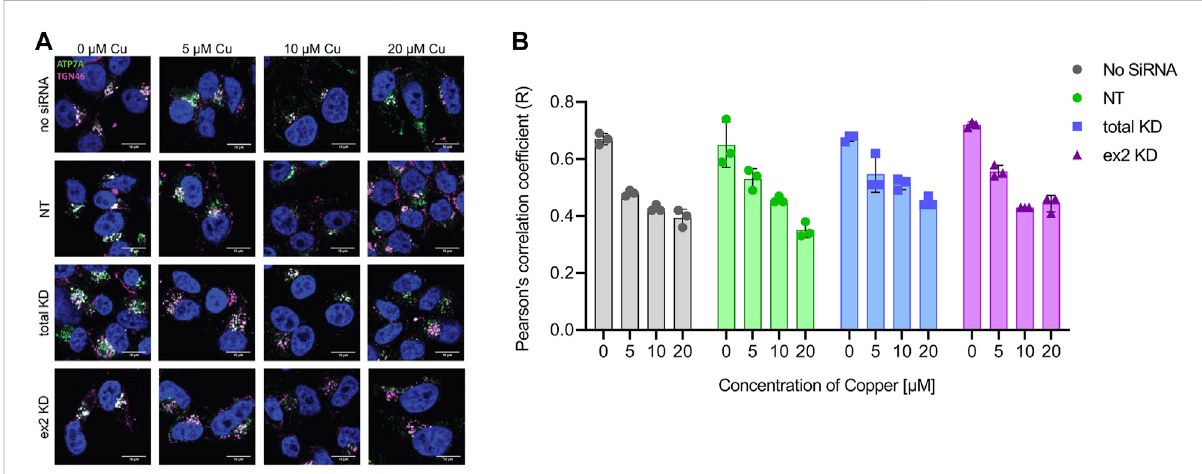
FIGURE 3 hnRNPA2/B1 downregulation in HeLa cells does not affect the traf fi cking of ATP7A in response to Cu. HeLa cells were transfected with no siRNA, non-targeting (NT) siRNA, siRNA against all 4 isoforms of hnRNPA2/B1 (total KD), or siRNA against the exon 2-containing B-isoforms of hnRNPA2/B1 (ex2 KD) for 72 h and then treated with the indicated concentrations of Cu for 4 h prior to staining (A) Immuno fl uorescence and confocal microscopy show that at basal levels, ATP7A is typically localized to the TGN and, upon Cu treatment, traf fi cs to vesicles. Pattern of ATP7A staining relative to the TGN in response to Cu. ATP7A is stained in green, TGN marker TGN46 in magenta, and thenucleus (DAPI) in blue. Co- localizationbetweenATP7AandTGN46isindicatedbywhitecoloration.Sizebar10 µm (B) Pearson ’ scorrelationcoef fi cient(R)valuesforATP7Aand TGN46 colocalization show similar changes in response to increasing Cu concentration for the control (no siRNA, NT) and a total KD and ex-2 KD cells). R was calculated using Coloc2 plugin of ImageJ Software ( n = 3 per